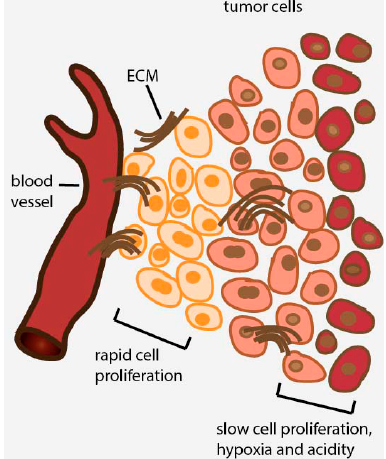
Figure 1. Development of heterogeneity in solid tumors. Continuous outgrowth of the vasculature results in the generation of tumor microenvironments that are characterized by hypoxia and nutrient starvation. Cells in these environments are slowly proliferating and are relatively insensitive to cell cycle-active cancer therapeutics. Extracellular matrix